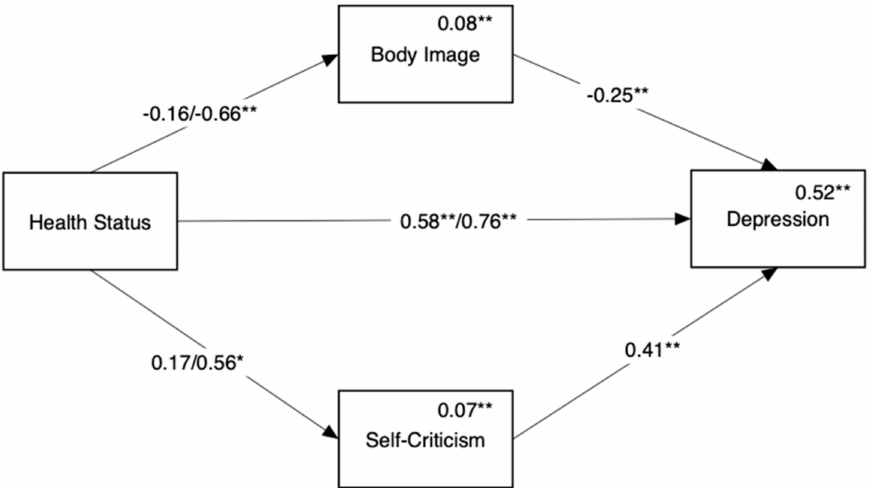
Figure 2. Mediation of the link between disease status and depression by body image and self- criticism. Reference group for comparison in the healthy controls. Numbers above the direct links are standardized regression coefficients. For paths originating from disease status, coefficients for endometriosis only appear on the left and coefficients for endometriosis ACI appear on the right. Numbers above variable names are multiple squared correlations. * p < 0.05, ** p < 0.01.